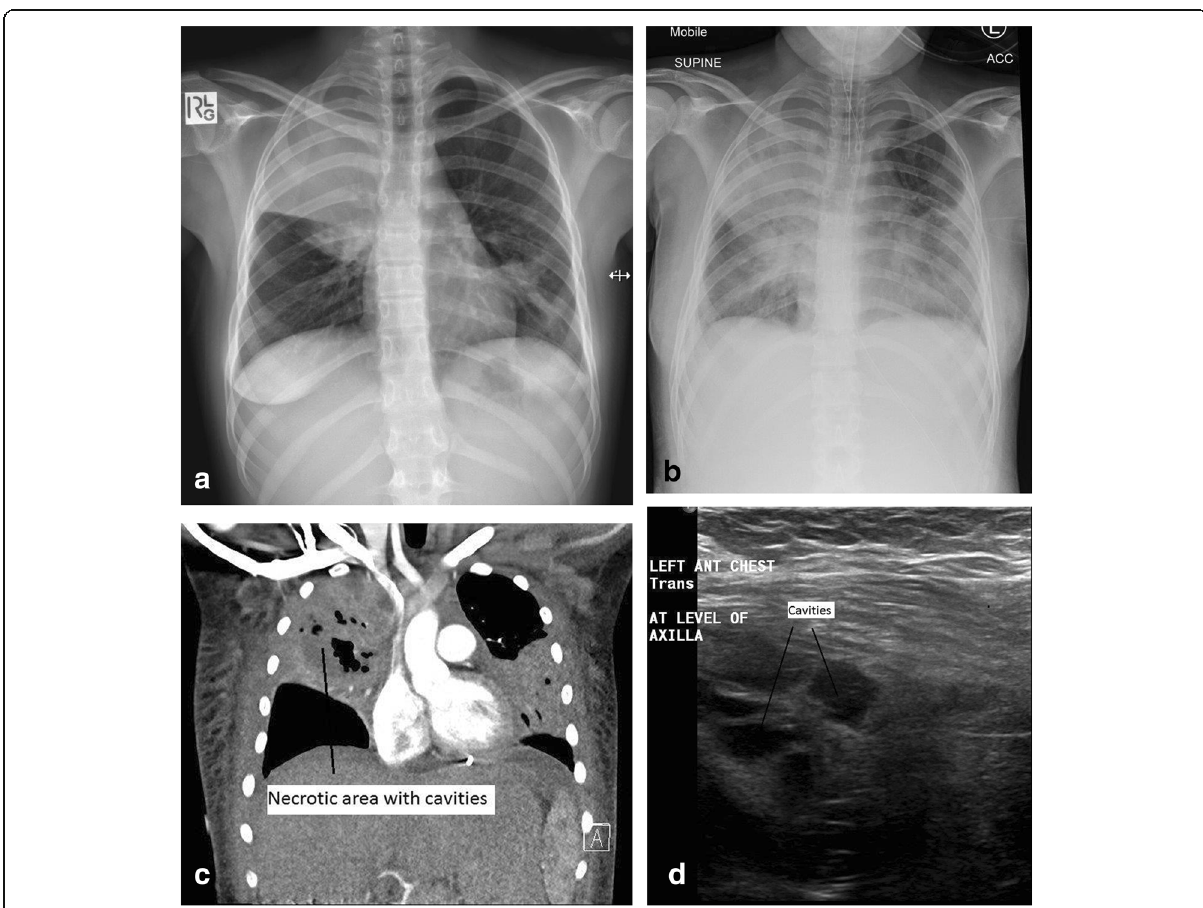
Fig. 2 A 14-year-old child presenting with 5 days of fever, cough, and sore throat. Over the next 24 h the patient developed progressive respiratory and multi-organ failure. S. constellatus (of the S. anginosus group) was cultured from pleural fluid collected on the second day of hospitalization. a Initial plain chest radiograph showing a dense right upper zone airspace opacity and lingula airspace changes, consistent with multi-focal pneumonia. The following images were performed 24 h later. b Plain chest radiograph with the child intubated and ventilated revealing cavitation in the right mid to upper zones, pleural effusion and more general airspace changes bilaterally. c Computed tomography (CT) scan, coronal view, demonstrating non-enhancing area (necrotic) thin-walled cavities within the right upper lobe and lingula. d Lung ultrasonographic image displaying